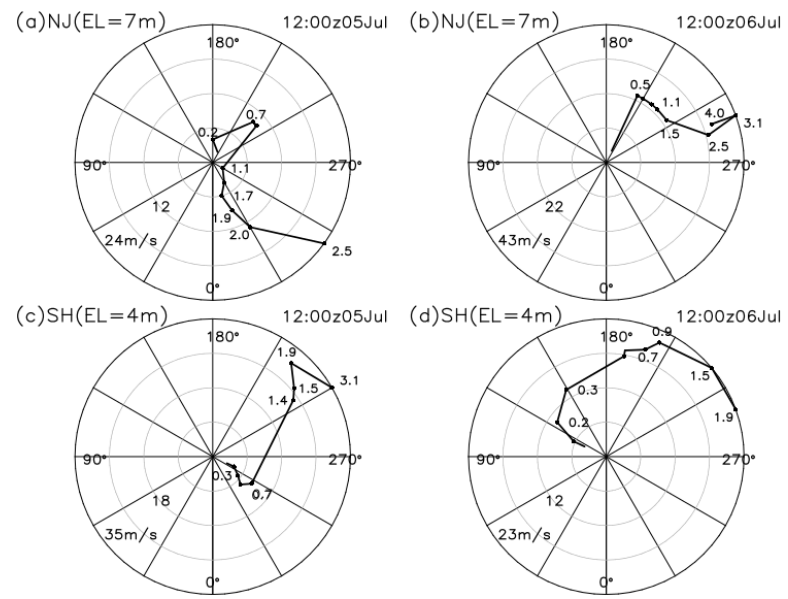
Figure 4. The observed winds (units: m ⋅ s −1 ) of Nanjing (NJ) site at ( a ) 12 p.m. UTC on 5 July and ( b ) 12 p.m. UTC on 6 July; ( c , d ) are the same as ( a , b ), but for ShangHai (SH) site.